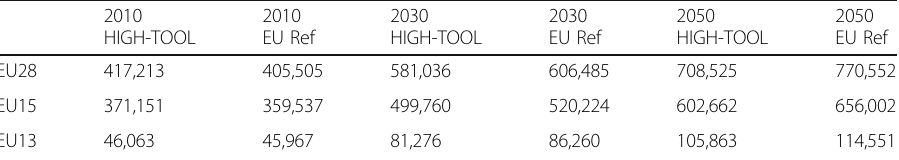
Table 1 HIGH-TOOL results vs. EU Ref, rail passenger transport demand (million